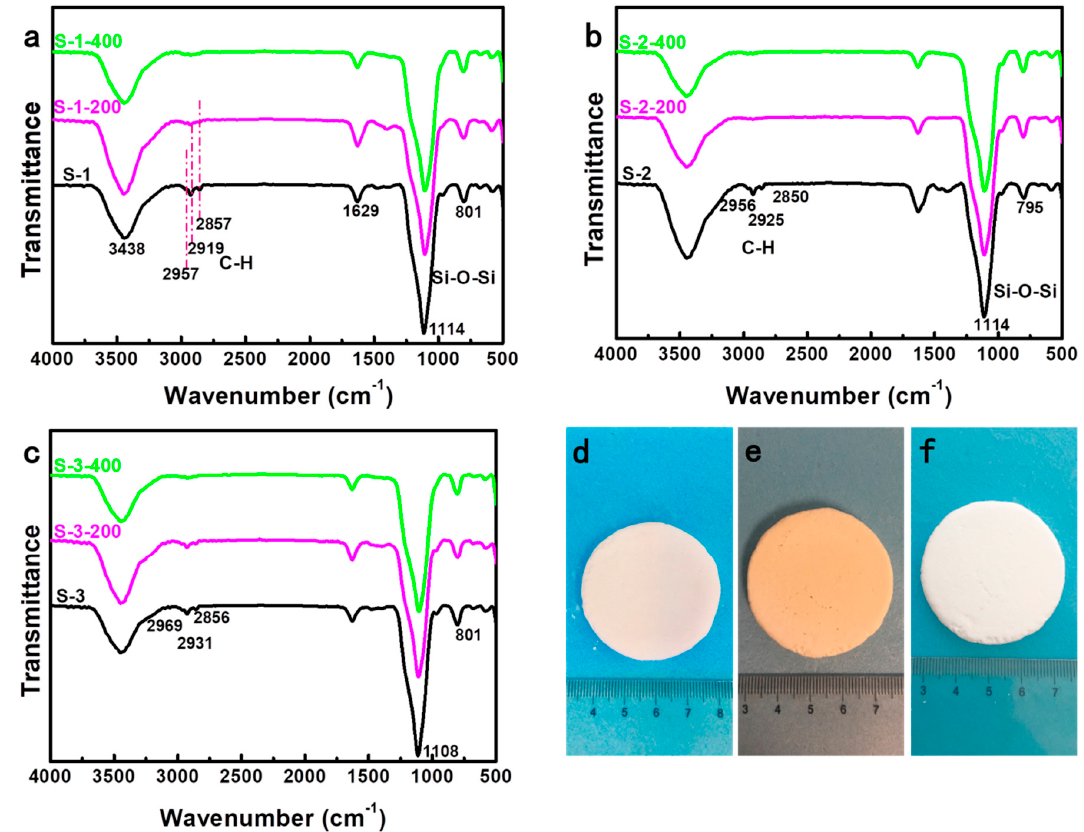
Figure 5. FTIR spectra of the silica aerogels: ( a ) S-1, ( b ) S-2, and ( c ) S-3 before and after heat treatment at 200 °C and 400 °C, respectively. ( d – f ) Representative photographs of silica aerogels prepared with sodium dodecyl sulfate (SDS) before and after heat treatment at 200 °C and 400 °C, respectively.